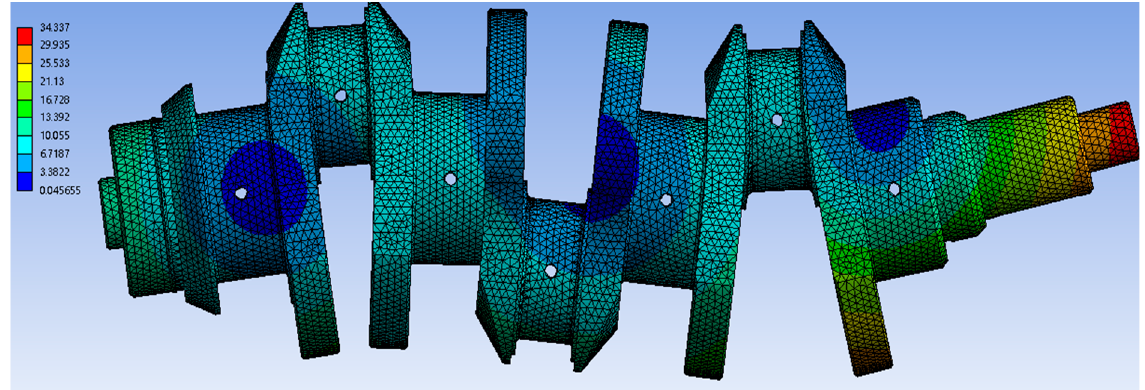
Figure 6. Eighth order mode vibration diagram.